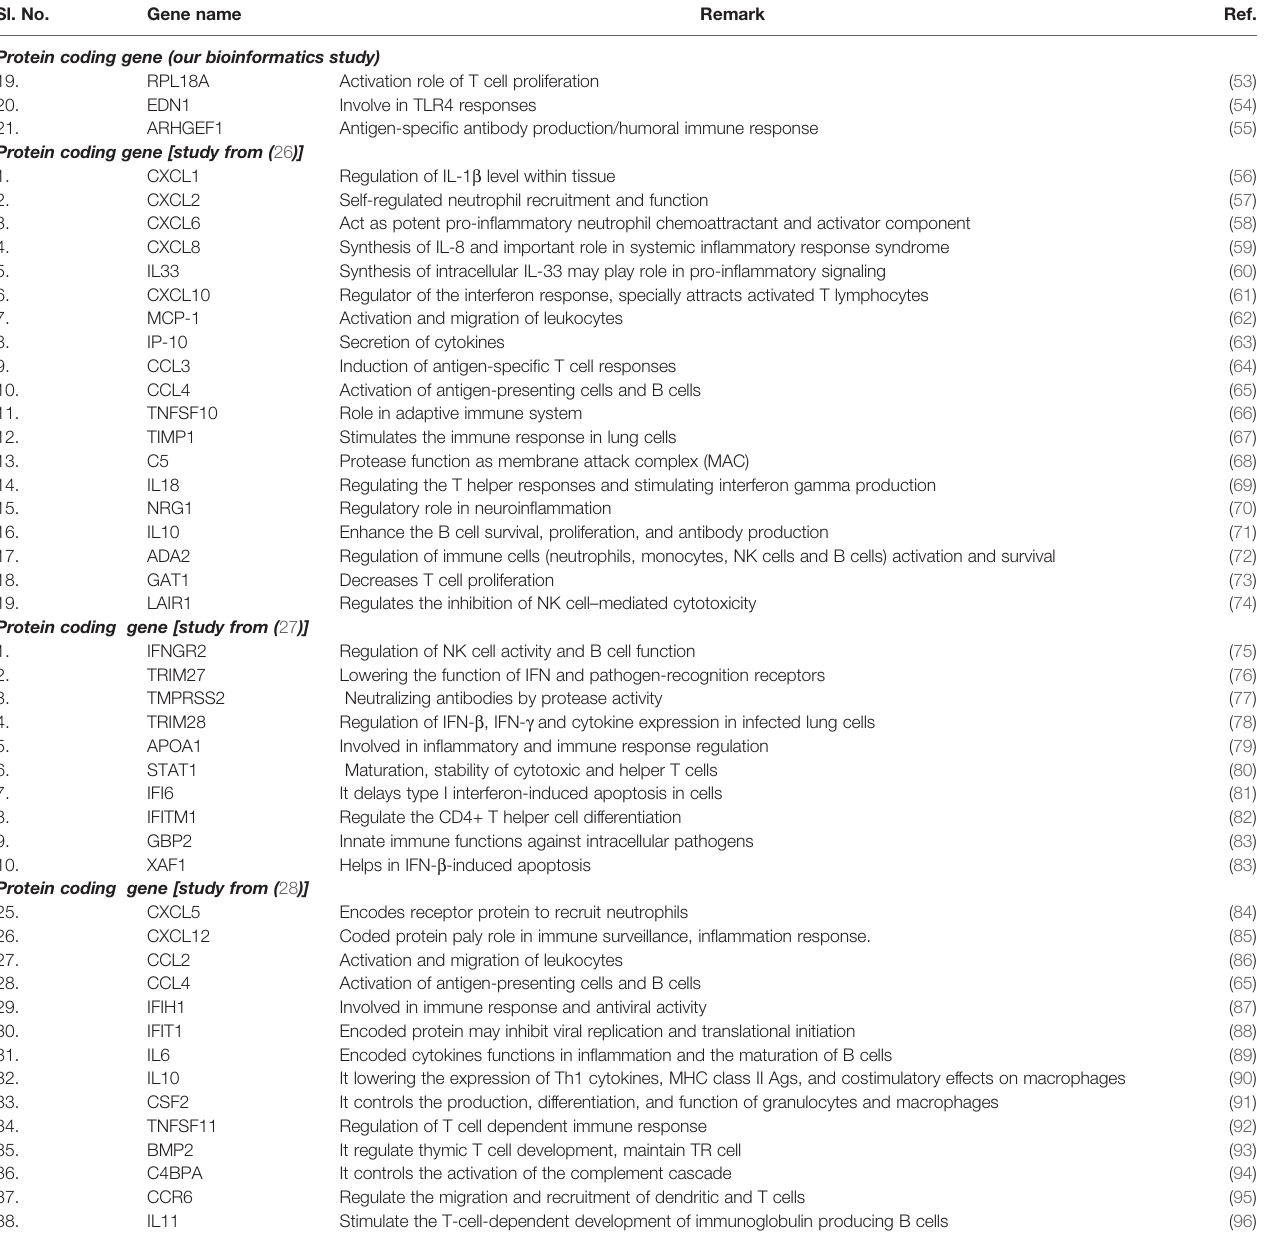
TABLE 5 | Annotated genes related to the activation of immune cells and components as well as for protective immunity function from our analysis and other experiments. Sl.